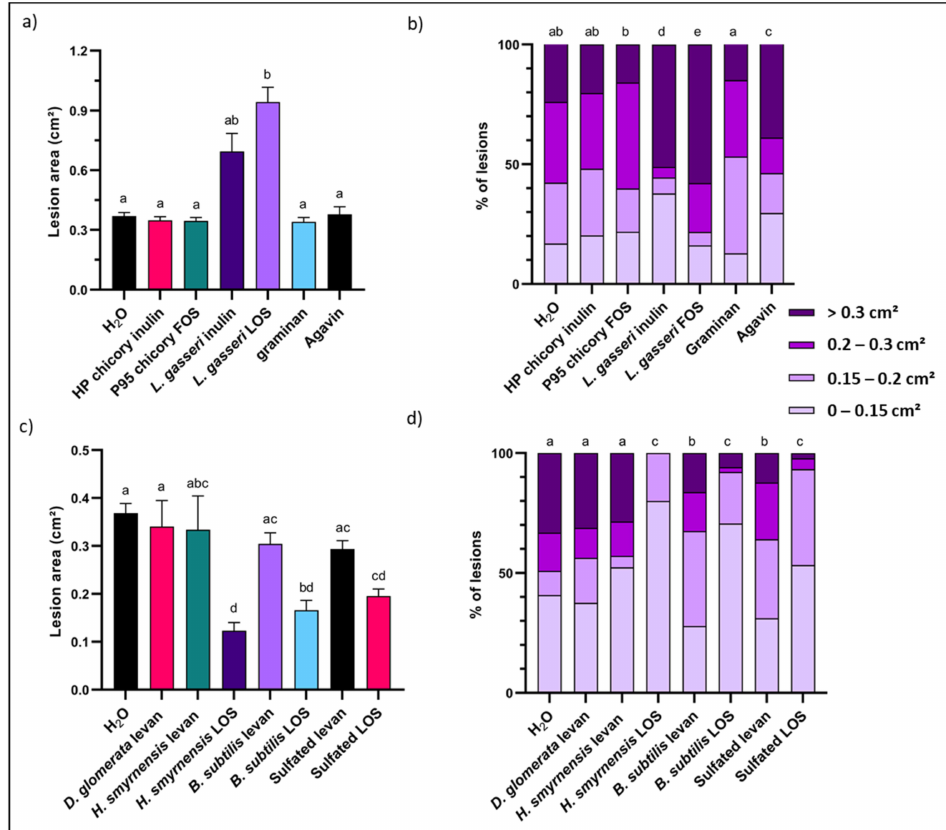
Figure 4. Priming efficacy of an array of fructans in the rocket- Botrytis cinerea pathosystem. After 72 h of priming, leaves were detached, rinsed and inoculated with B. cinerea spores. Infection progressed for 72 h before disease scoring. ( a ) Average lesion area for different inulin-type fructans (chicory or Lactobacillus gasseri ), as well as Triticum aestivum graminan and Agave tequilana agavin. ( b ) Percentage of lesions belonging to each of four different classes based on lesion size for inulin and branched fructans. ( c ) Average lesion area of levan priming agents ( Dactylis glomerata , Halomonas smyrnensis and Bacillus subtilis ). For H. smyrnensis , a sulfated levan was also tested. Bars represent the mean ± SEM. ( d ) Percentage of lesions belonging to each of the four classes with different lesion size for levan and LOS priming. All fructans were sprayed at 5 g L − 1 , with at least 30 biological replicates per treatment. The experiments were repeated three times with consistent results. Letters indicate significant differences between treatments ( p <